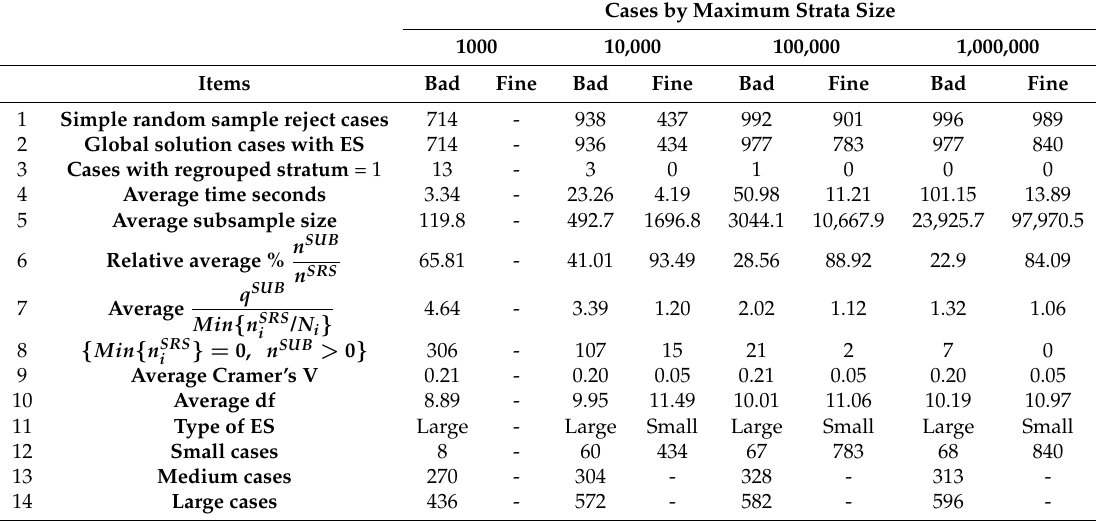
Table 1. Summary of the simulation results. Source: own. Two scenarios per strata size band: